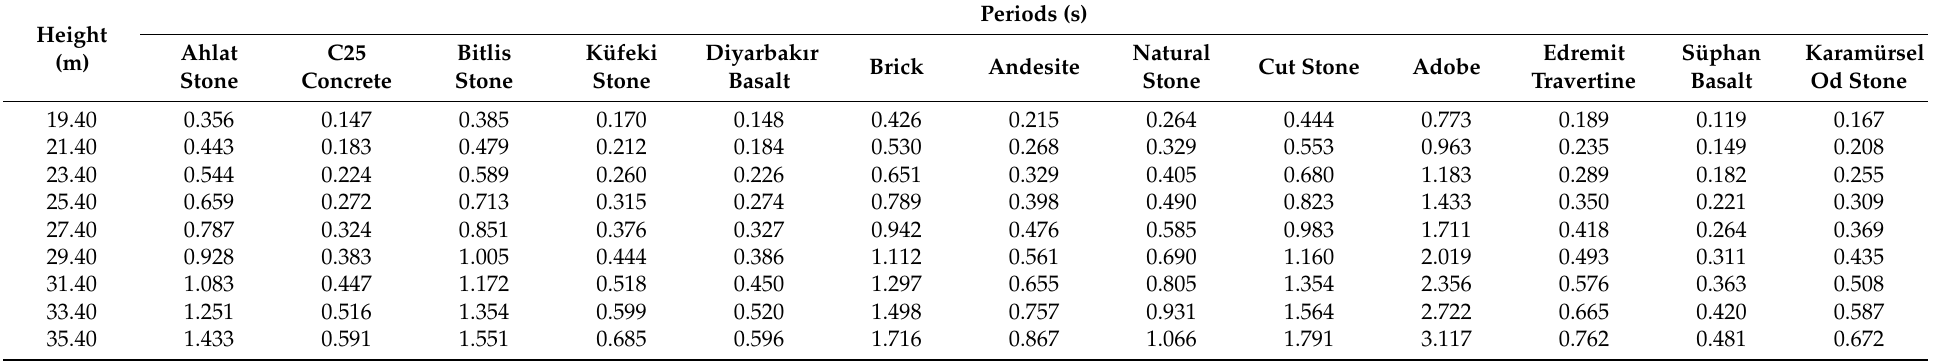
Table 7. The comparison of natural fundamental